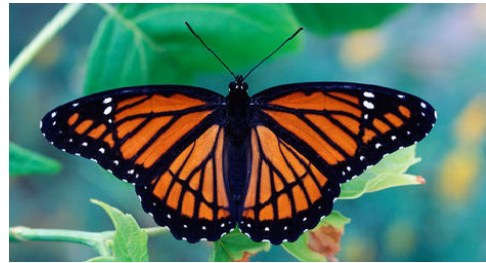
Figure 5. Original Image.